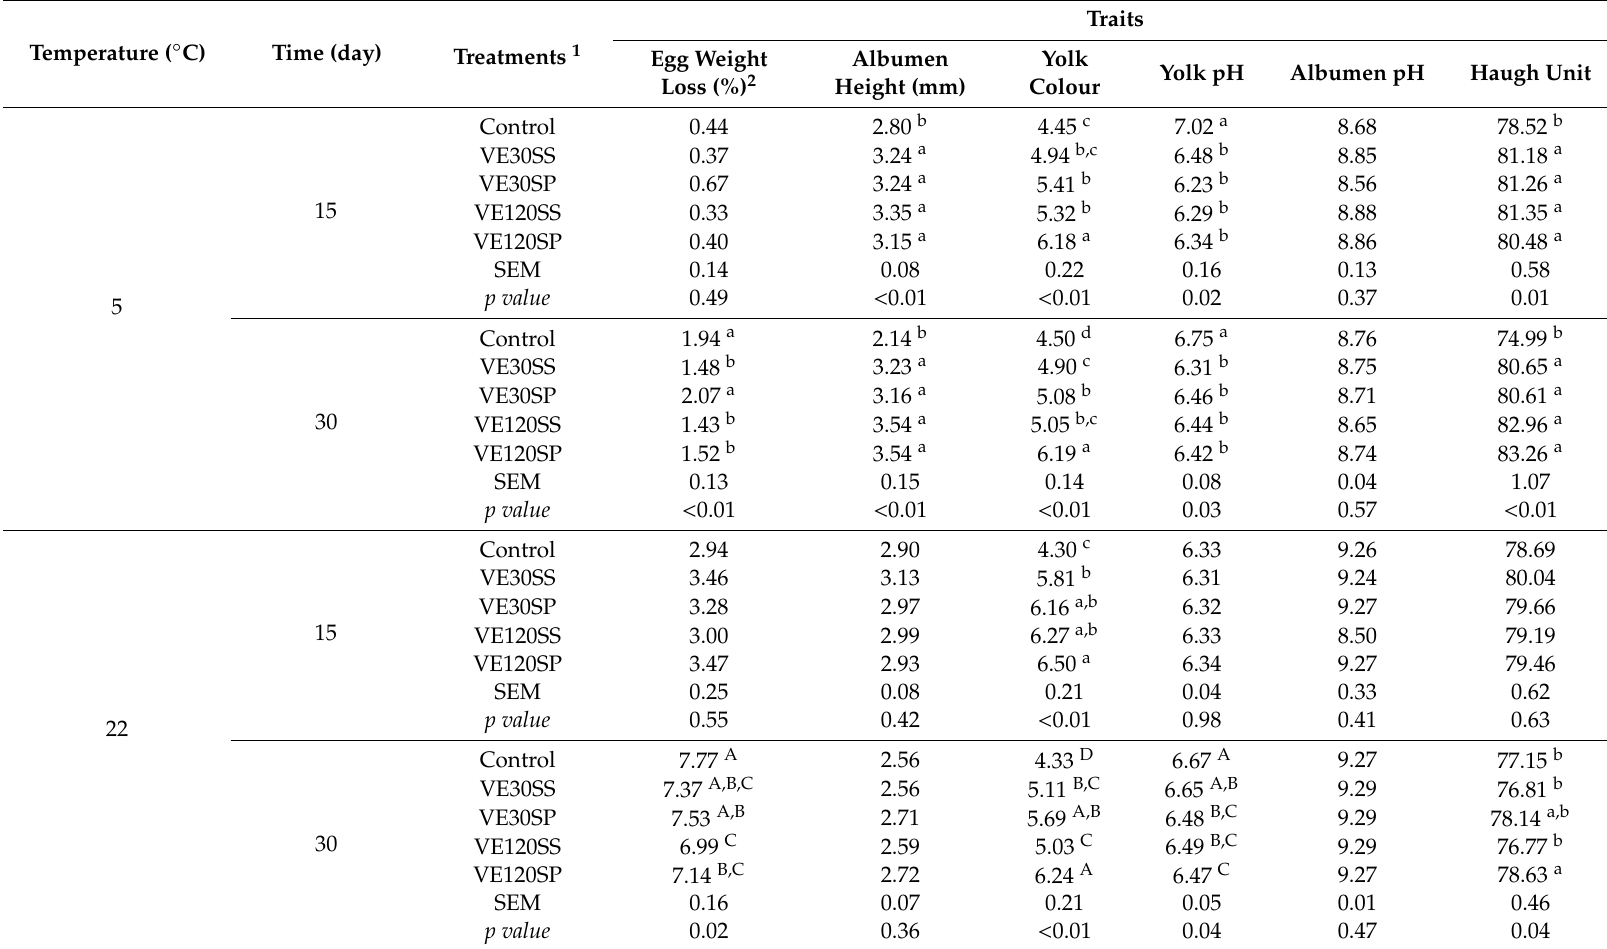
Table 3. Quality traits of stored eggs from Japanese quails fed di ff erent levels of vitamin E and selenium sources.